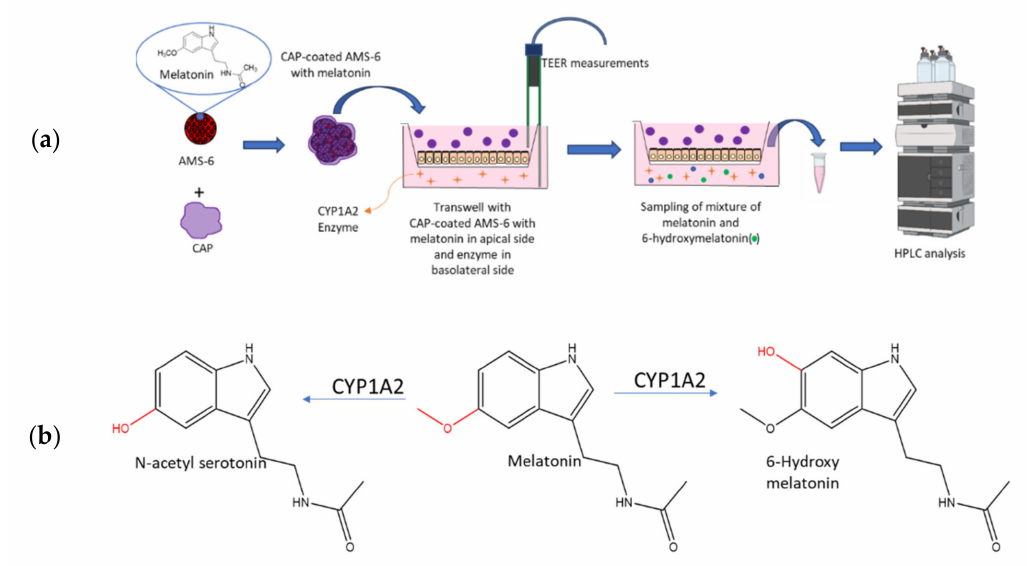
Figure 1. ( a ) Schematic representation of the formulation studied in this work and the Caco-2 cell model utilised to determine the effect of the release rate on the metabolism of melatonin from the formulation. Melatonin was loaded into mesoporous silica via a wetness impregnation of the hormone, using ethanol as the solvent, followed by evaporation using a rotary evaporator. A similar process was used to coat mesoporous silica with CAP. See the Materials and Methods Sections 2.3 and 2.4. ( b ) Main products of the catabolism of melatonin in the liver of vertebrates by cytochrome P450 enzymes (CYP) such as CYP1A1, CYP1A2, CYP1B2 or CYP2C19